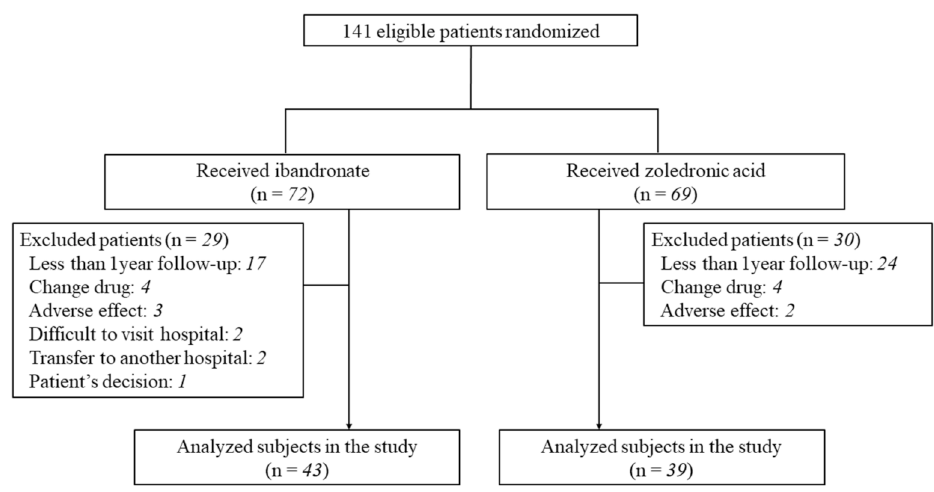
Figure 1. Participant flowchart of this study. A total of 141 patients were randomly divided into groups receiving either oral ibandronate or intravenous zoledronic acid. Eighty-two subjects were analyzed after 59 patients were excluded due to such reasons as insufficient follow